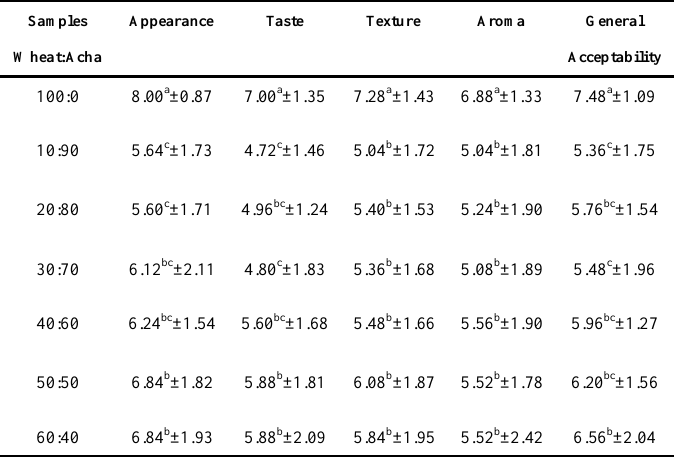
Values are means + standard deviation of duplicate determination. Mean values in the same column with different superscript are significantly different